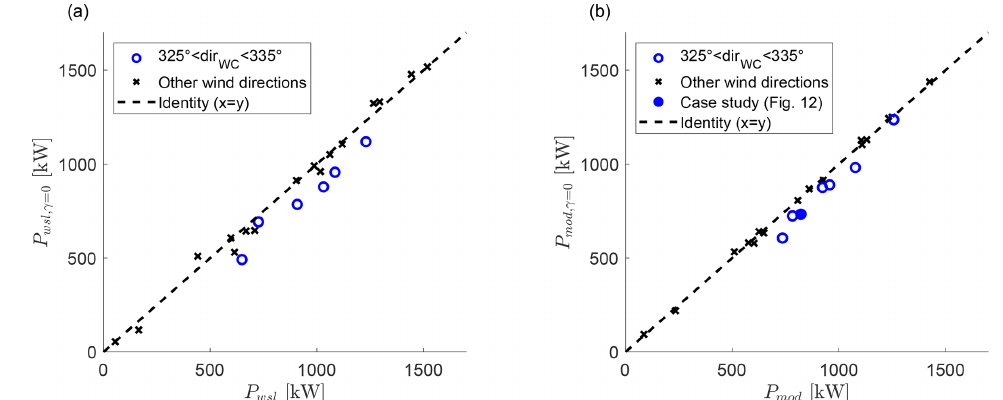
Figure 14. The effect of wake steering on the power of the downstream turbine (T3) based on the wake-scanning lidar (a) and the Qian and Ishihara (2018) model (b) . Data of the wake-steering cases with a 3D scan of wake-scanning lidar and a model prediction at x/D = 4 are used. The hollow blue circles indicate data points from the narrow inflow sector, the black crosses are data points outside of the narrow inflow sector, and the solid blue circle is the yawed example case from Fig.